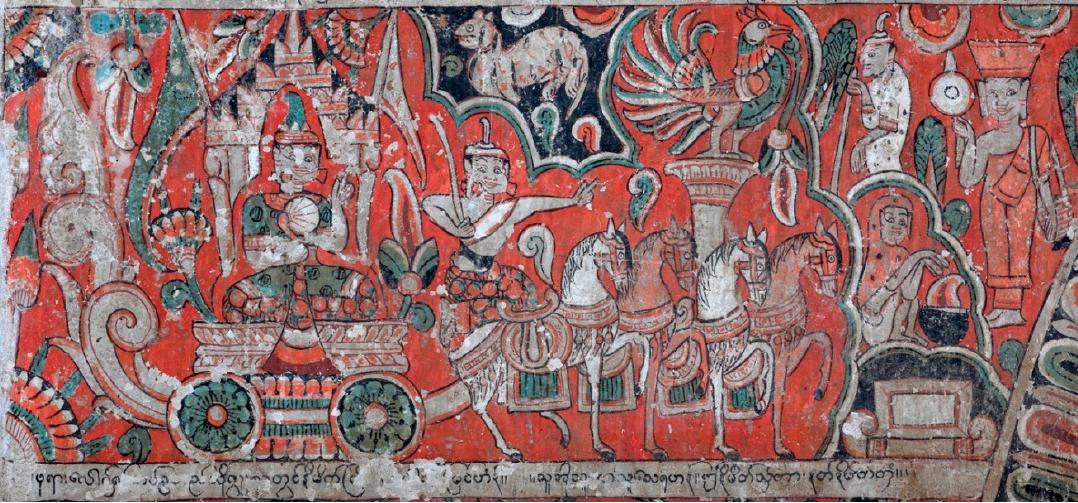
Figure 1. Salyingyi, 18th Century. The Four Omens. In the garden, the prince sees four beings, an old man, a sick man, a dead man and a recluse.